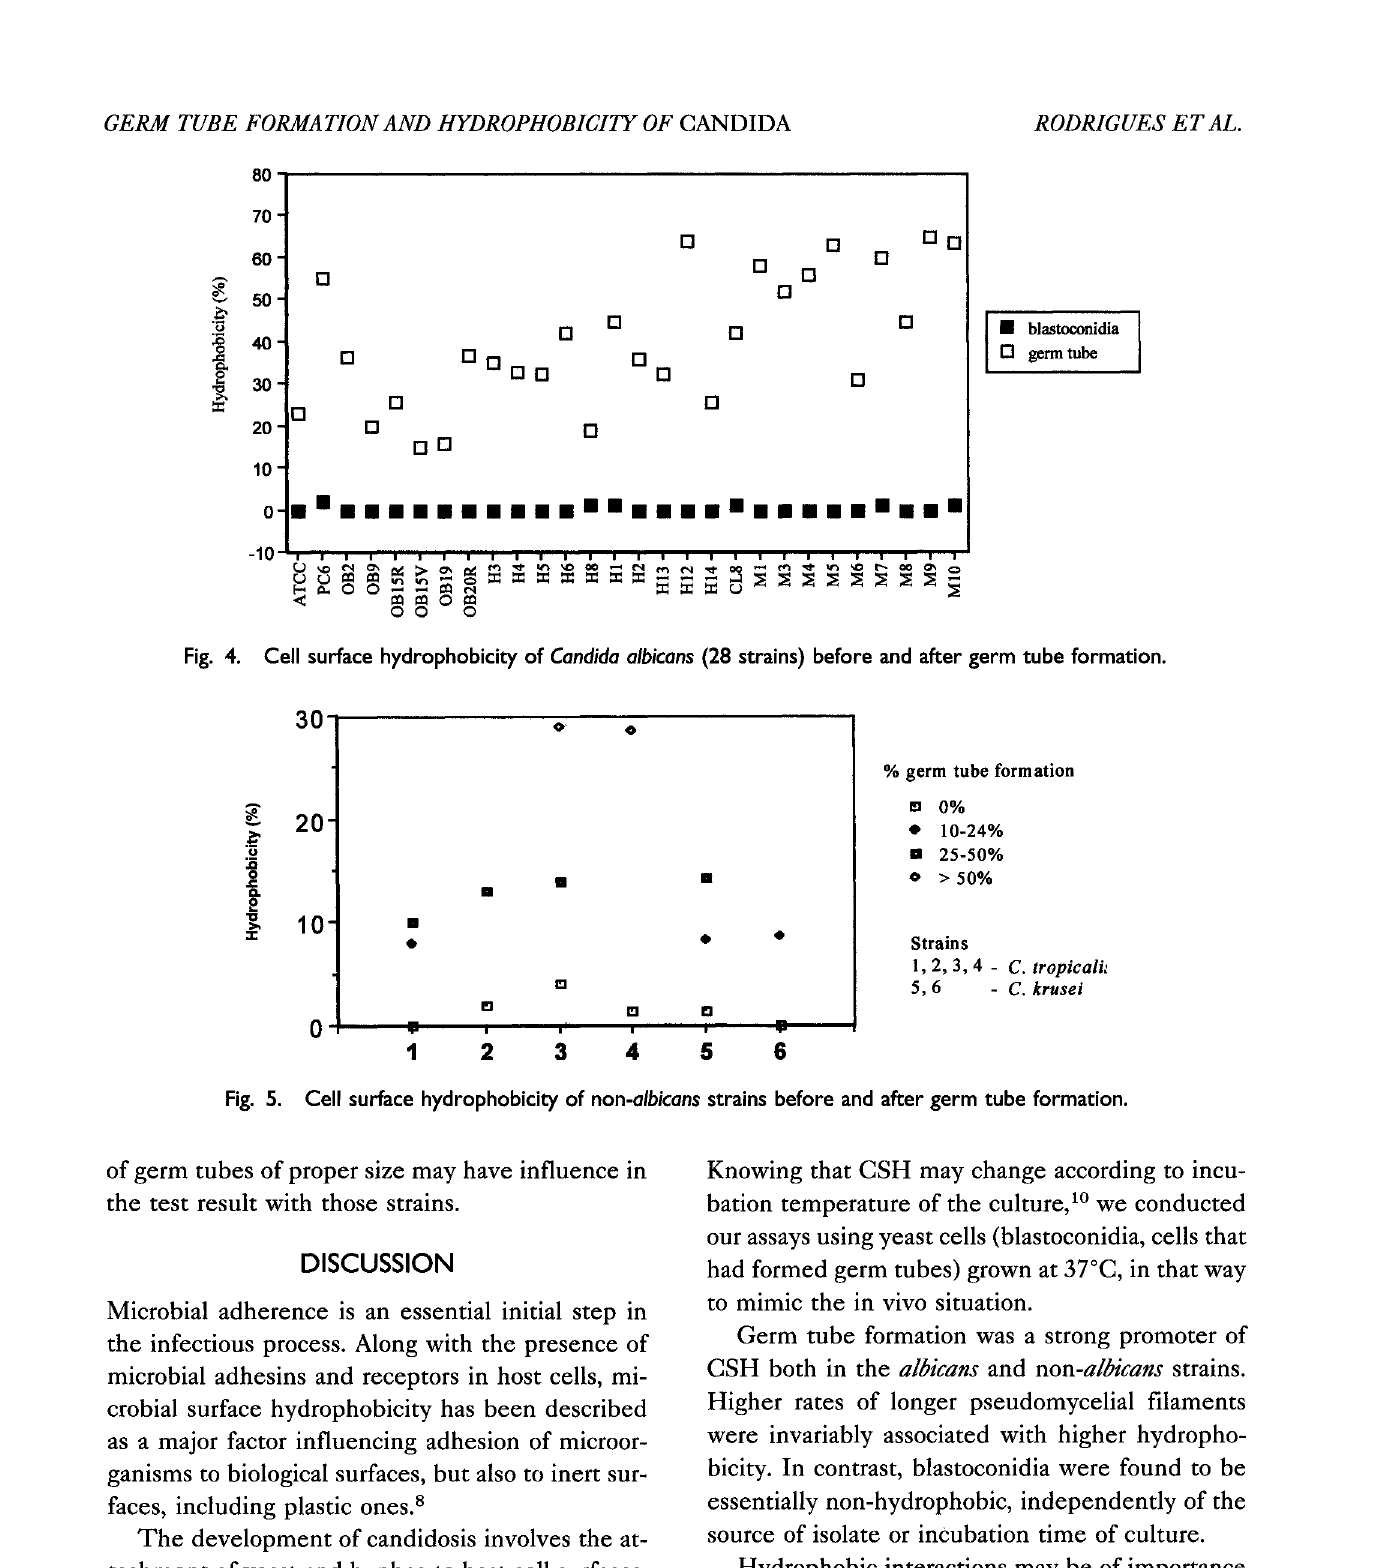
Fig. 4. Cell surface hydrophobicity of Candida albicans (28 strains) before and after germ tube formation.